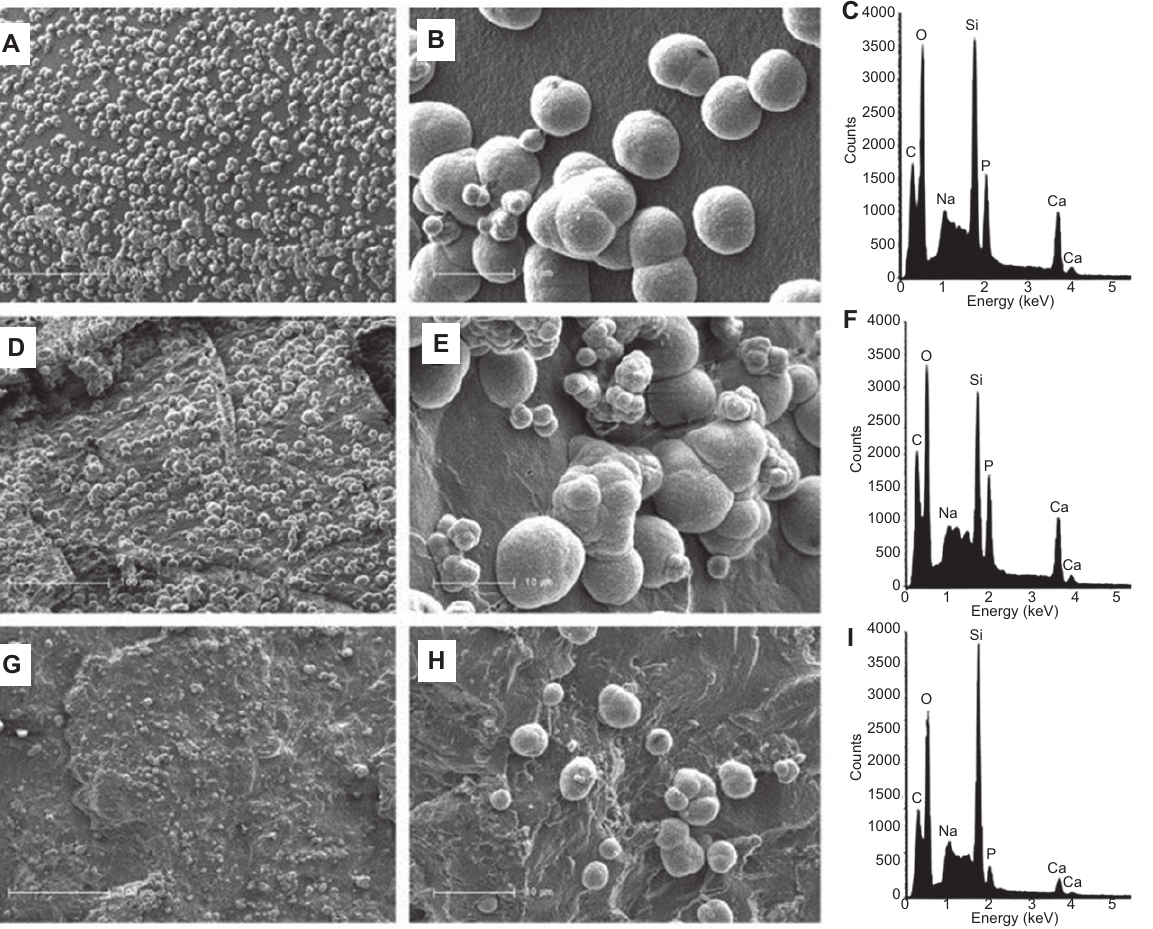
Figure 3 Representative SEM images and EDX spectra of silica xerogel (A – C), silica/collagen 85/15 (D – F) and 70/30 (G – I) composite xero- gels after 7 days of incubation in SBF. The scale bars of SEM images show 100 μm (first column) and 10 μm (second column), according to Heinemann et al. [18] . Reproduced with permission from